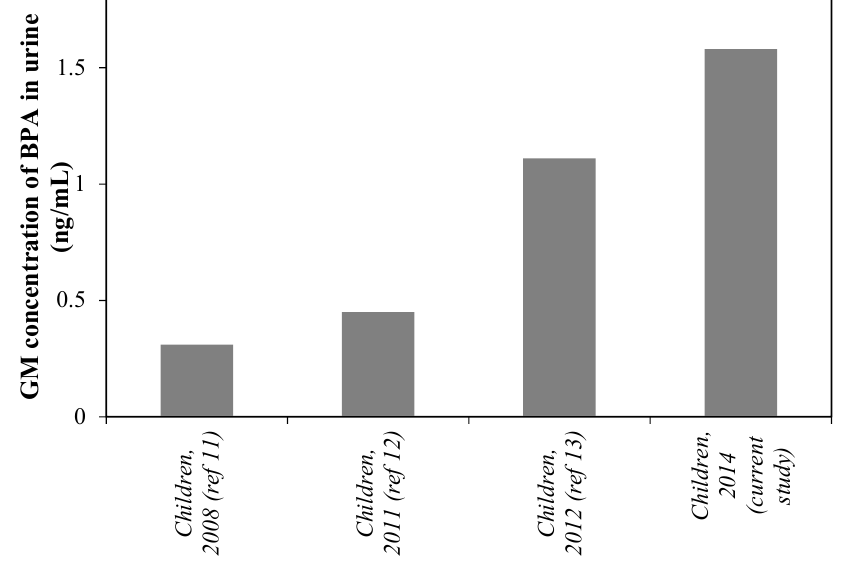
Figure 1. Chronological changes of GM concentration urinary BPA in children from China; the data comes from references [11–13] and the results of the current study.